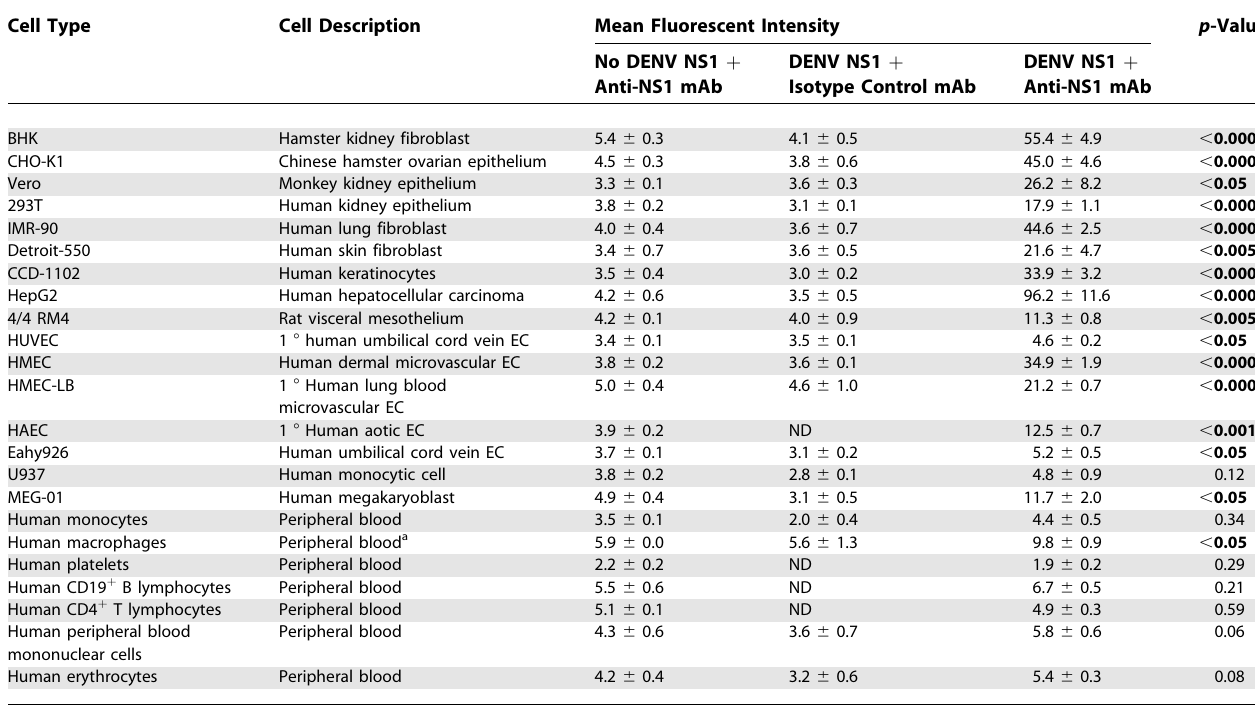
Table 1. DENV NS1 Binds to a Variety of Cell Types Cell Type Cell